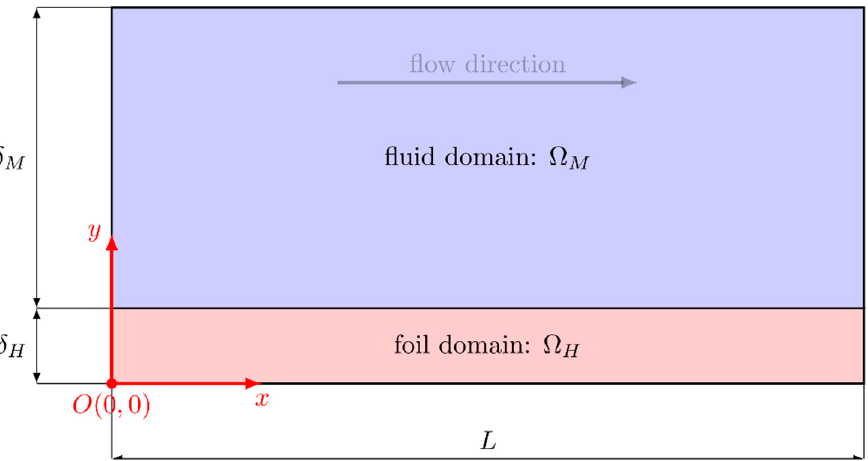
Figure 2. The scheme of the main domains of the test section (fluid and foil) considered in the cal ‐ culations.